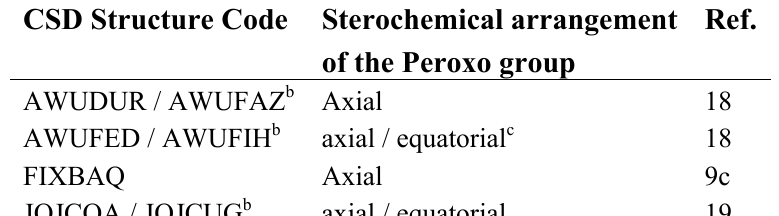
Table 1 . Conformational situation a of the peroxo groups in molecular structures